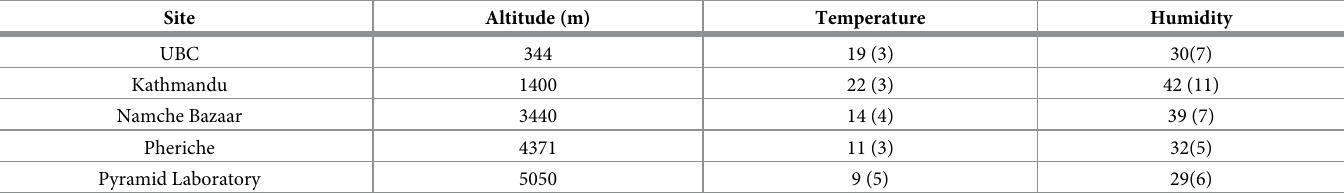
Table 3. Environmental variables at each testing site.